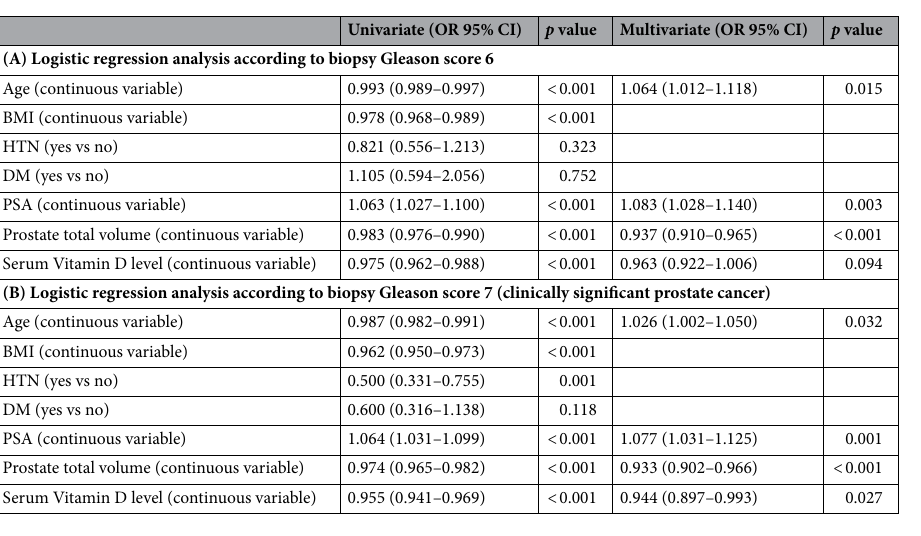
Table 3. Univariate and multivariate logistic regression analysis of Asian patients with prostate biopsy ( n = 171). BMI body mass index, HTN hypertension, DM diabetes mellitus, PSA prostate-specific antigen, CI confidence